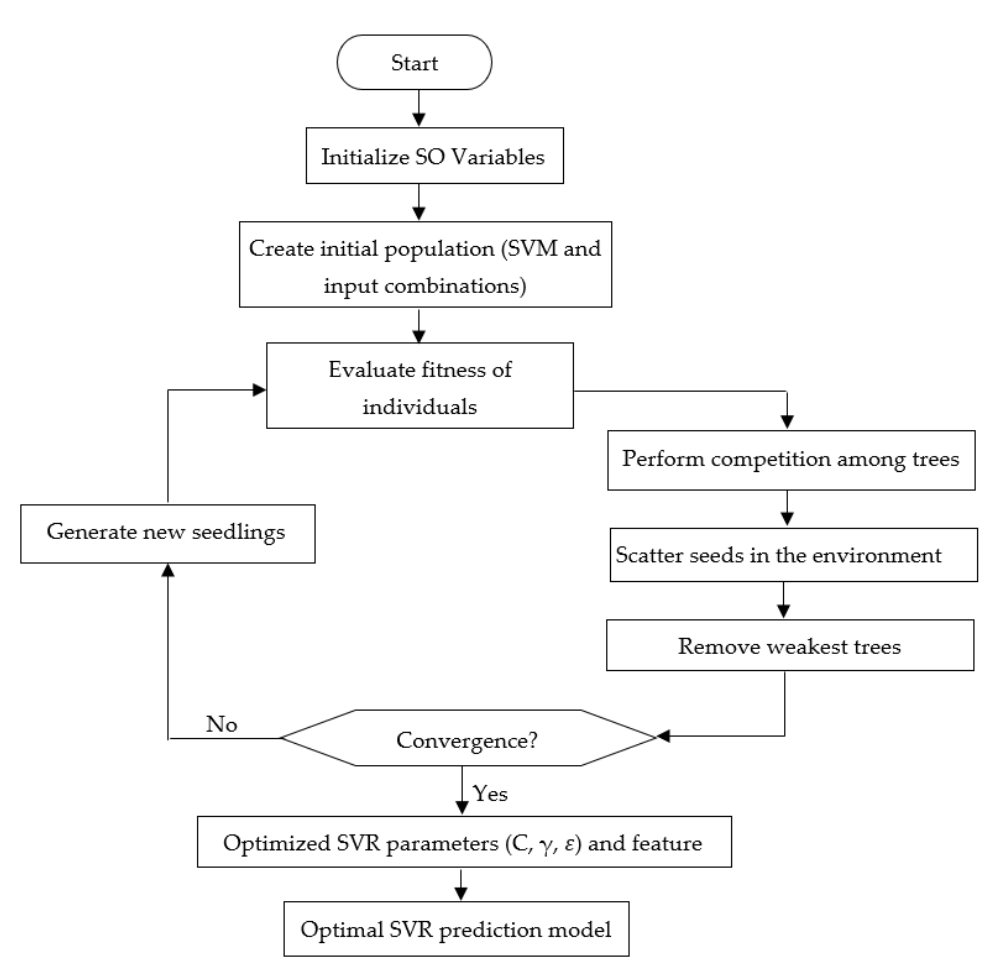
Figure 3. Flowchart of the SO– support vector regression (SVR). Table 4. Range of dataset